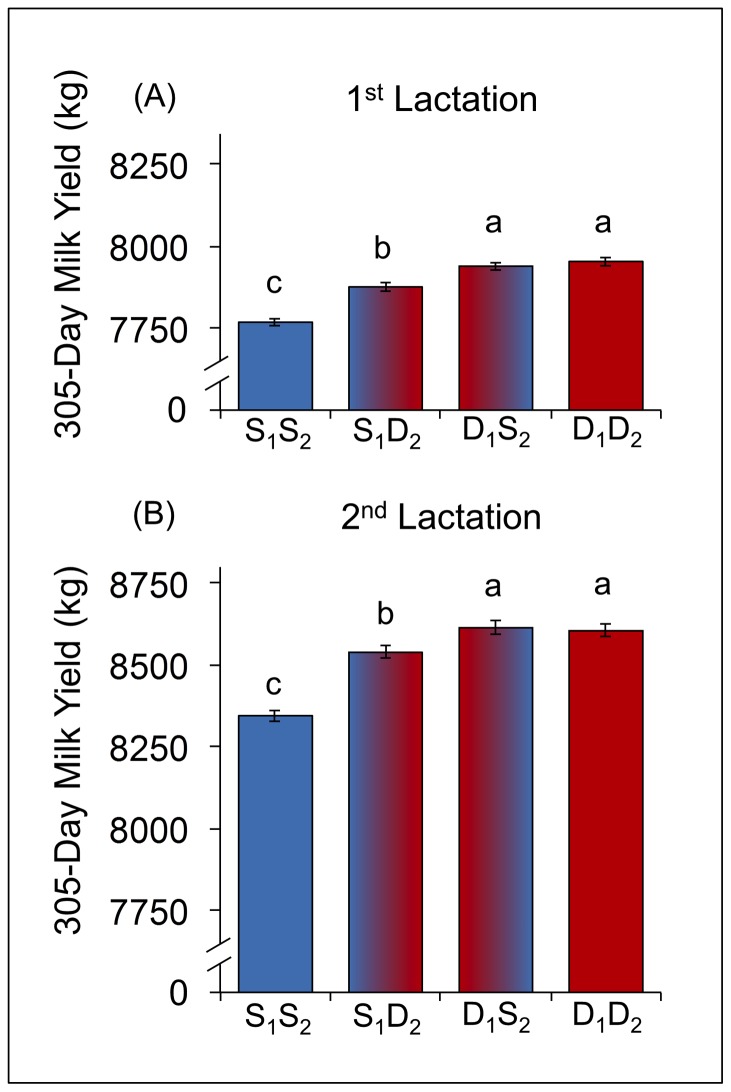
Daughters confer milk production advantages post-natally, during gestation, and across multiple lactations.Cows (n = 113,750) with both first and second parity lactation records, with no reports of dystocia or bST administration, were used to assess effects of calf sex on milk production in the first 2 lactations. Groups are labeled by calf sex (S = son, D = daughter), with the pregnancy denoted by subscript. Values are LS means ± SEM. Means labeled with different letters differ (P<0.001), and those with common labels do not (P>0.10). A) First-parity cows having a daughter produced significantly more milk than those having a son, but gestating a daughter in pregnancy 2 increased milk production in cows that had a son first. B) Second-parity milk production is greatest in cows that had a daughter in pregnancy 1. Additionally, cows with a son in pregnancy 1 showed increased milk production if they had a daughter in pregnancy 2.